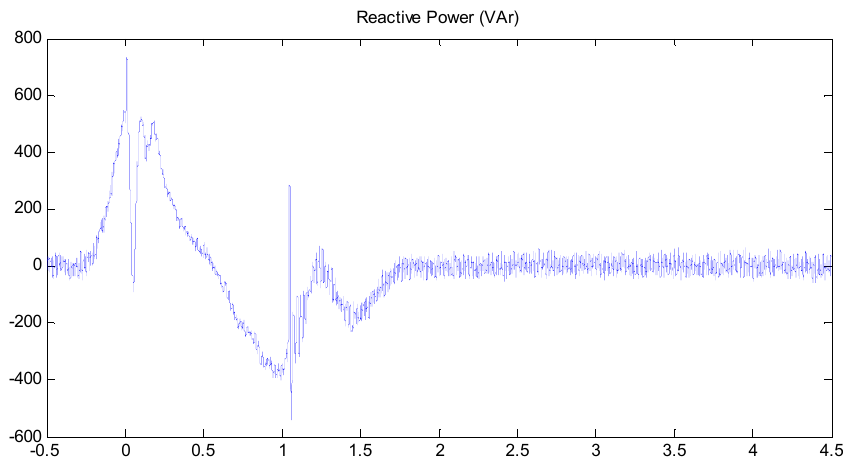
Figure 19. Reactive power, (VAr) vs. time, (s).